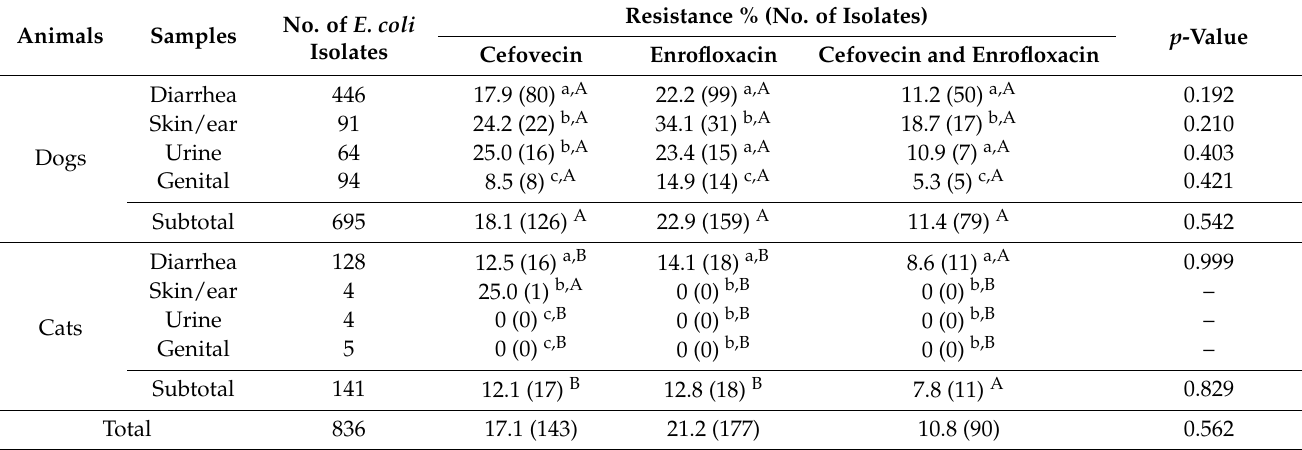
Table 1. Cefovecin and enrofloxacin resistance in E. coli isolated from diseased dogs and cats during